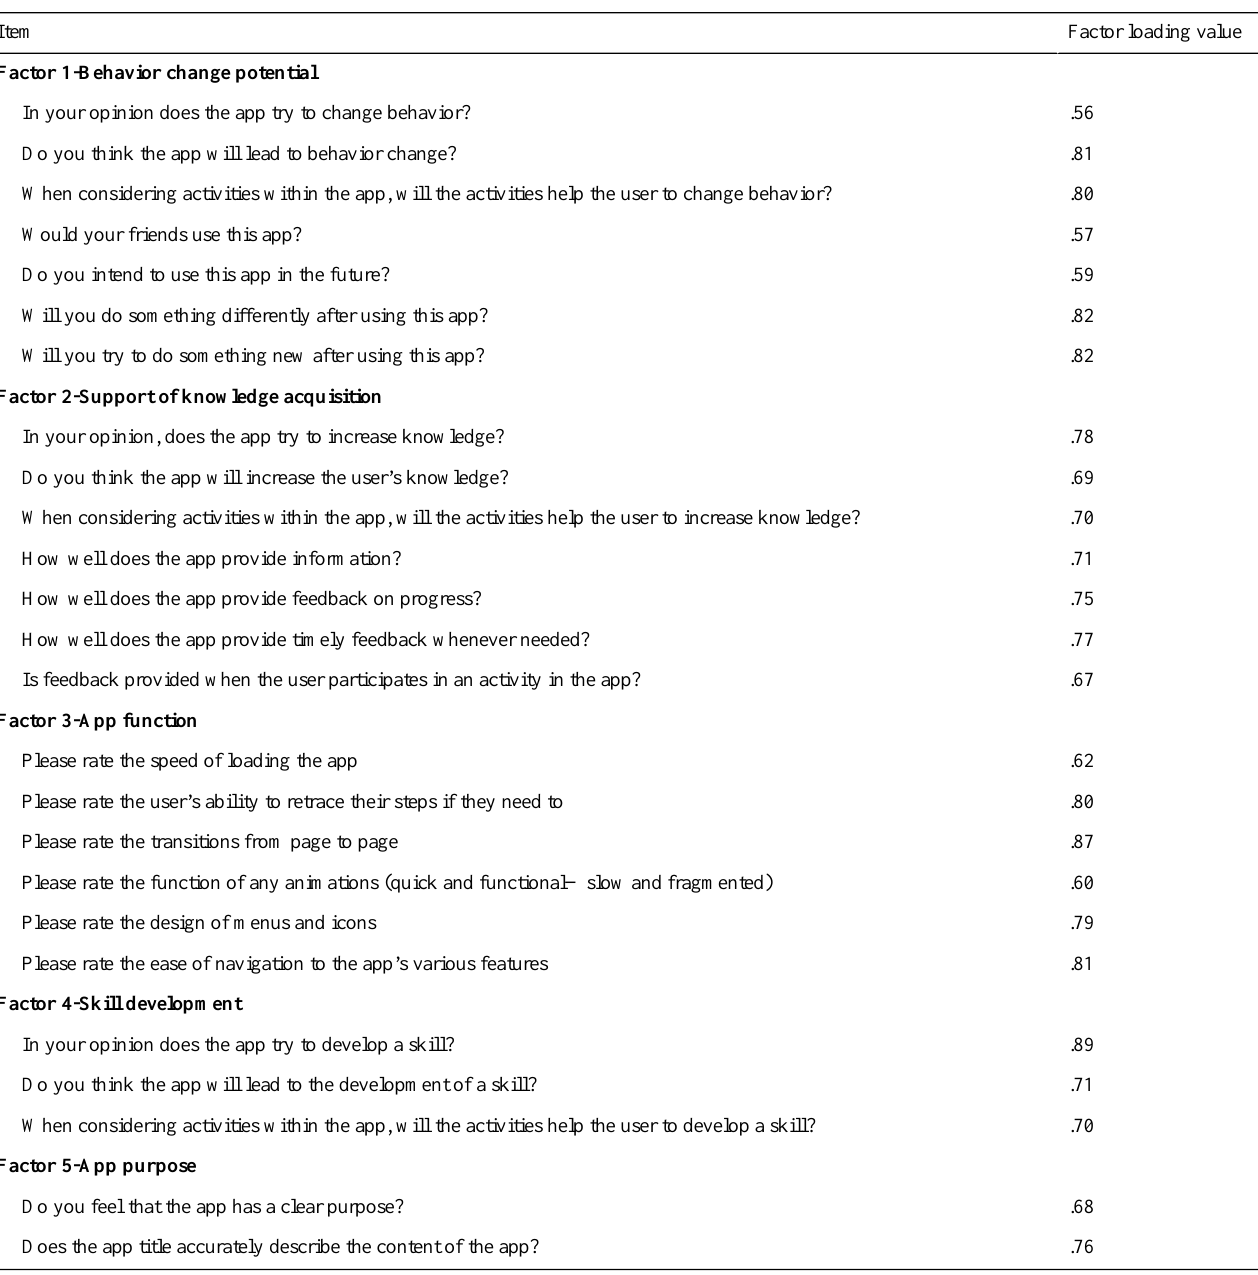
Table 1. Primary factor loadings of items assessing nutrition app